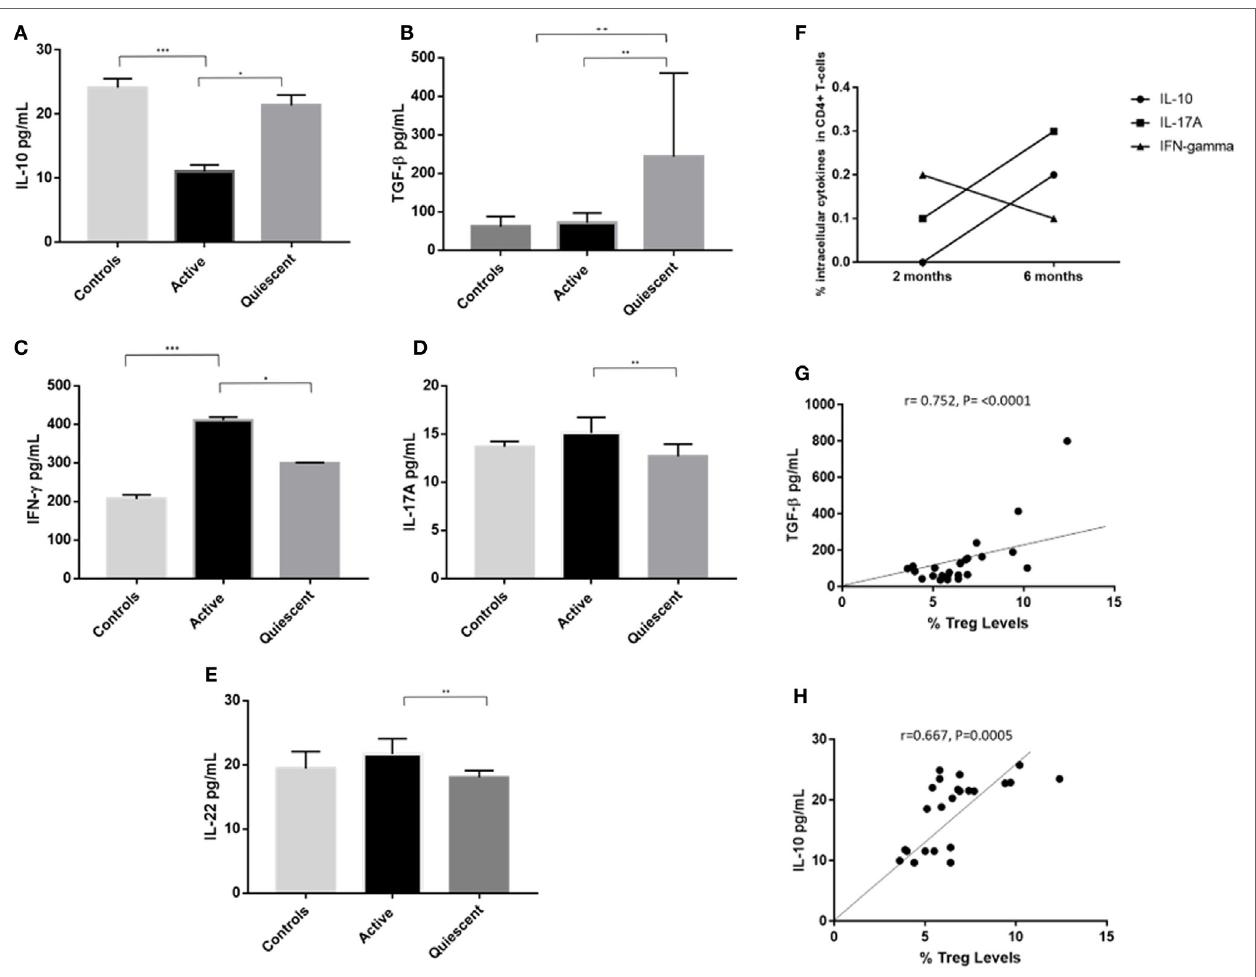
FigUre 7 | Serum cytokines levels (pg/mL) of IL-10, IFN γ , IL-17A, IL-22, and transforming growth factor β (TGF- β ) in the three subject groups (active, remission, and controls), intracellular levels of IL-10, IFN γ , and IL-17A, and correlation of serum IL-10 and TGF- β levels with T-regulatory cell (Treg) levels. (a) Serum IL-10 levels. (B) Serum IFN γ levels. (c) Serum IL-17A levels. (D) Serum IL-22 levels. (e) Serum TGF- β levels. (F) Intracellular levels of IL-10, IFN γ , and IL-17A in the CD3 + CD4 + compartment of T-cells in a patient with active disease at 2 and 6 months after starting immunosuppressive treatment, following 24 h in vitro culture with anti-CD3 and anti-CD28 bead stimulation. (g) Bivariate correlation of serum TGF- β (pg/mL) and % Treg frequency, across all subject groups. (h) Bivariate correlation of serum IL-10 levels (pg/mL) and % Treg frequency, across all subject groups.